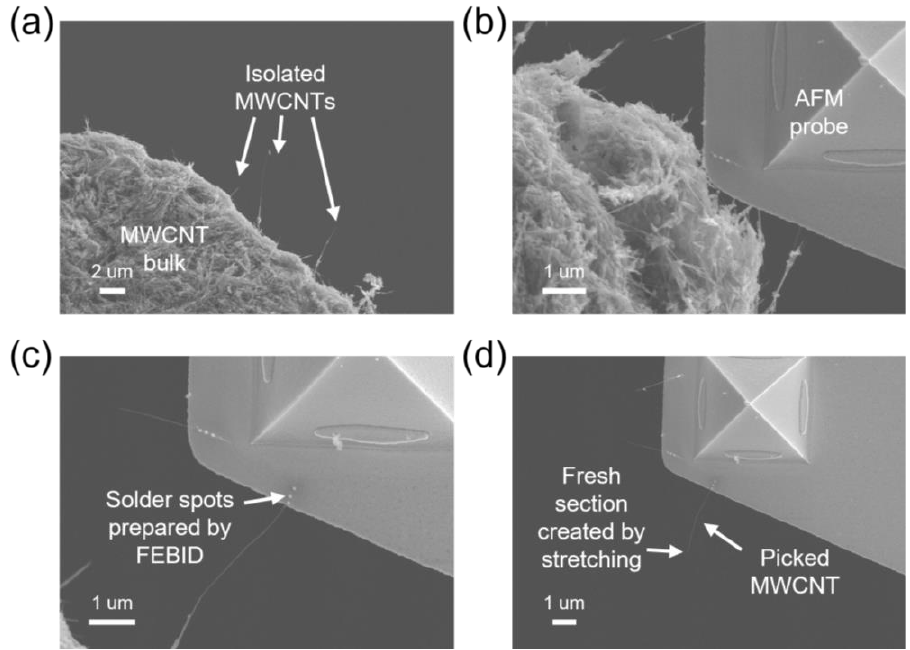
Figure 2. The picking-up process of an isolated MWCNT from the MWCNT bulk with our NRM. ( a ) SEM image of the MWCNT bulk with isolated MWCNT sticking out of the bulk surface; ( b ) approaching process of an AFM probe carried by the NR manipulator; ( c ) welding operation to mount the MWCNT to probe’s surface, where solder spots prepared by the FEBID method can be seen; ( d ) the picked MWCNT was stretched to breaking, generating a fresh section.